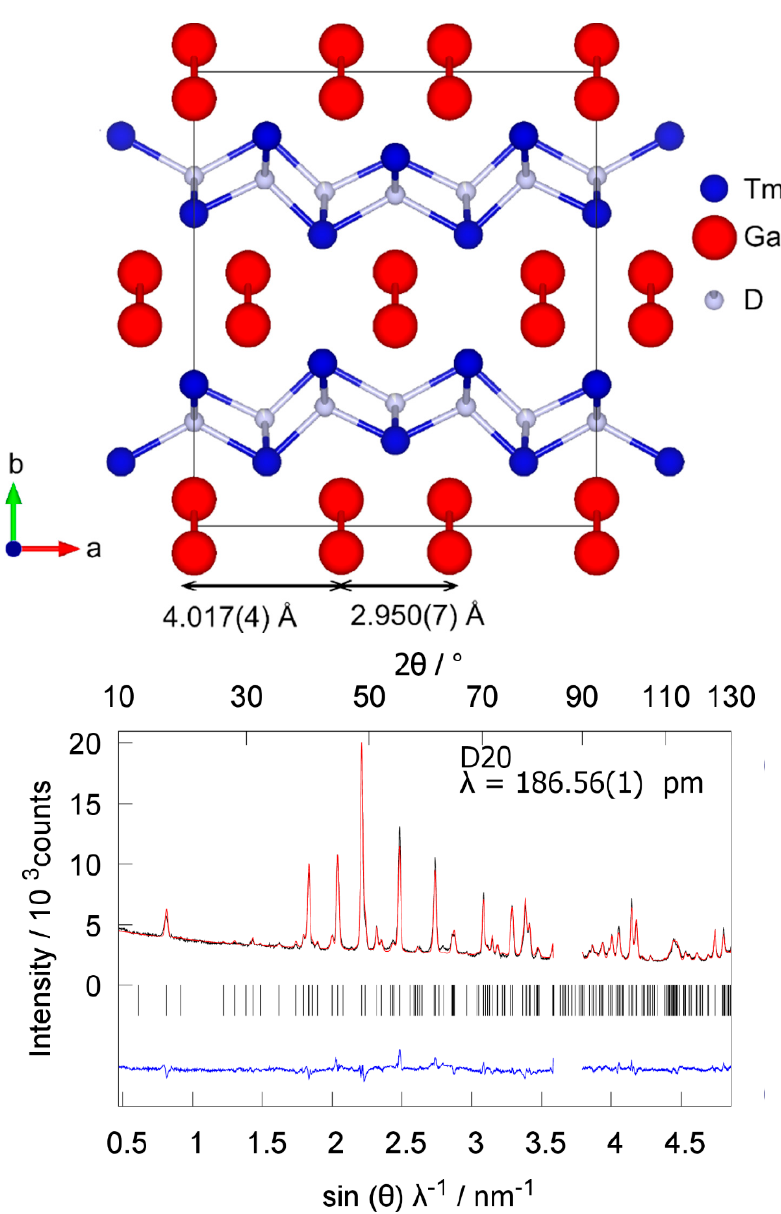
Figure 5. Top : crystal structure of TmGaD 0.93(2) ; bottom : Rietveld refinement of the crystal structure of TmGaD 0.93(2) derived from in situ neutron diffraction, 84° ≤ 2 Θ ≤ 90° excluded because of a strong reflection of the sample container, R p = 4.08%, R wp = 5.27%, GooF = 3.08.